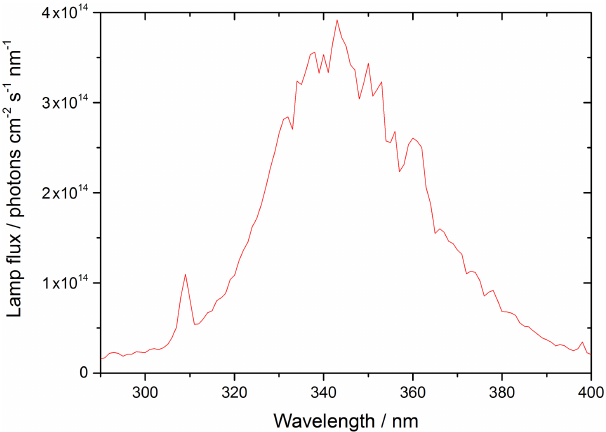
Figure 3. UVA emission spectrum for the 15W bench lamp used in these experiments between 290–400nm. The inte- grated photon flux over this wavelength range is (1.63 ± 0.09) × 10 16 photonscm − 2 s − 1 determined from the measured j (NO 2 ) of (6.43 ± 0.30) × 10 − 3 s − 1 .